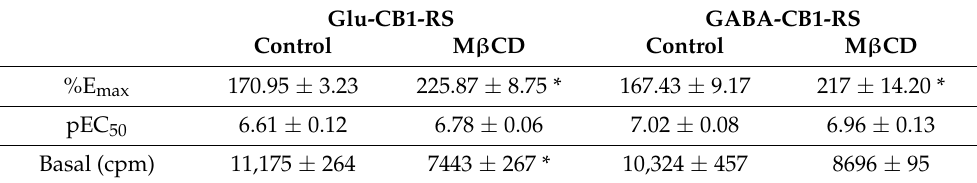
Figure 6. CB1 receptor coupling to G α i/o proteins in control and 10 mM M β CD pretreated synaptosomes from frontal cortical tissue of Glu-CB1-RS and GABA-CB1-RS mice. ( A , B ) Bar graph of 10 µ M CP 55,940 and 10 µ M WIN 55,212-2- stimulated maximal [ 35 S]GTP γ S binding. ( C , D ) Concentration–response curves for the CP 55,940-stimulated [ 35 S]GTP γ S binding. Concentration–response curves were constructed using mean values ± SEM from triplicate data points of three independent experiments. Emax values are expressed as % specific [ 35 S]GTP γ S bound of basal. Table 2. Concentration–response curves for the CP 55,940-stimulated specific [ 35 S]GTP γ S binding in vehicle (control) or M β CD pretreated frontal cortical synaptosomes derived from Glu-CB1-RS and GABA-CB1-RS mice. Values correspond to the means ± SEM of three independent experiments performed in triplicate, using synaptosomes enriched preparations obtained from a pool of the frontal cortices of eight adult mice. Unpaired (%E max ) or paired (pEC 50 , Basal) two-tailed